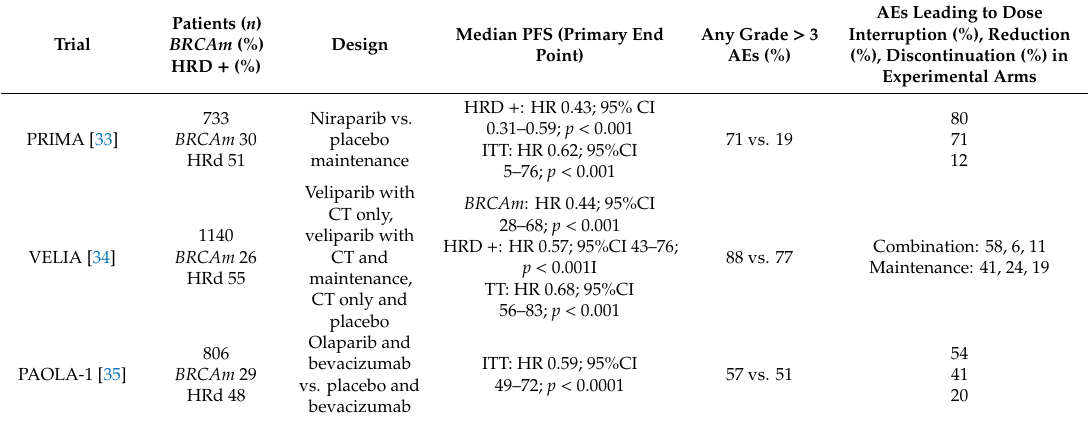
Table 1. Phase III trials of first-line PARP